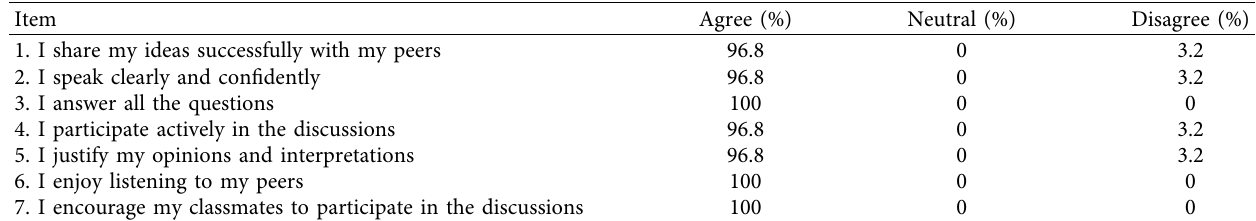
Table 3: Students’ self-evaluation of their performance and contribution in Literature Circles 2.0 sessions.